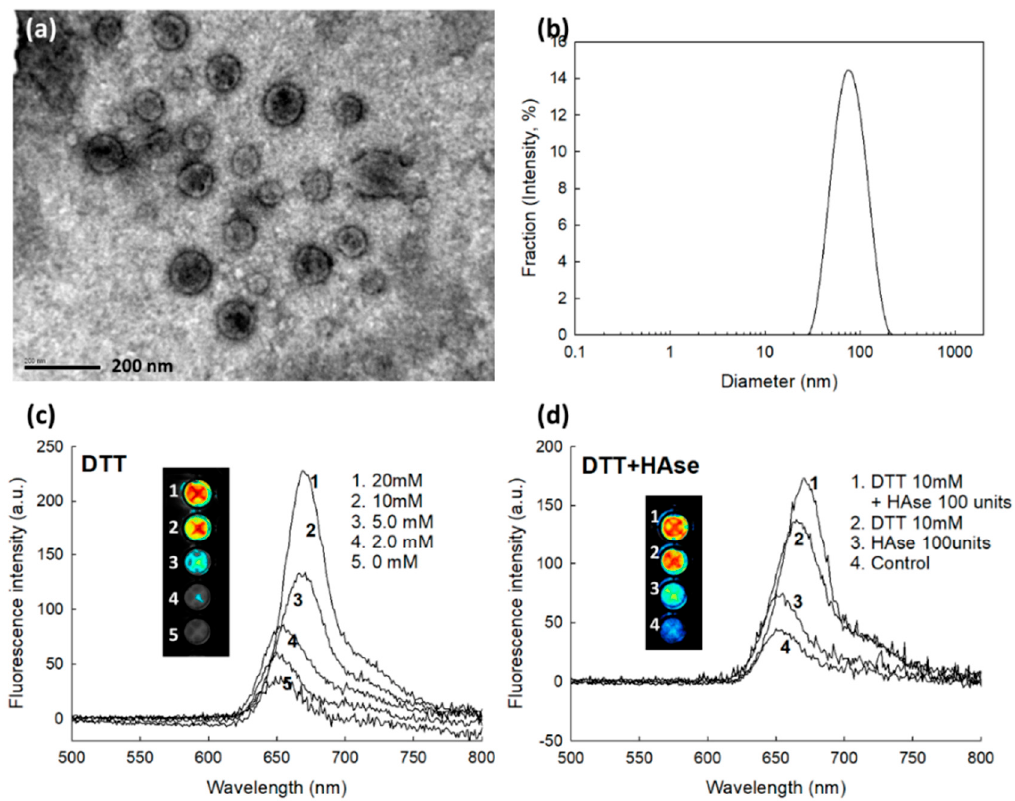
Figure 4. Morphological observation ( a ) and particle size distribution ( b ) of Ce6tetraHA